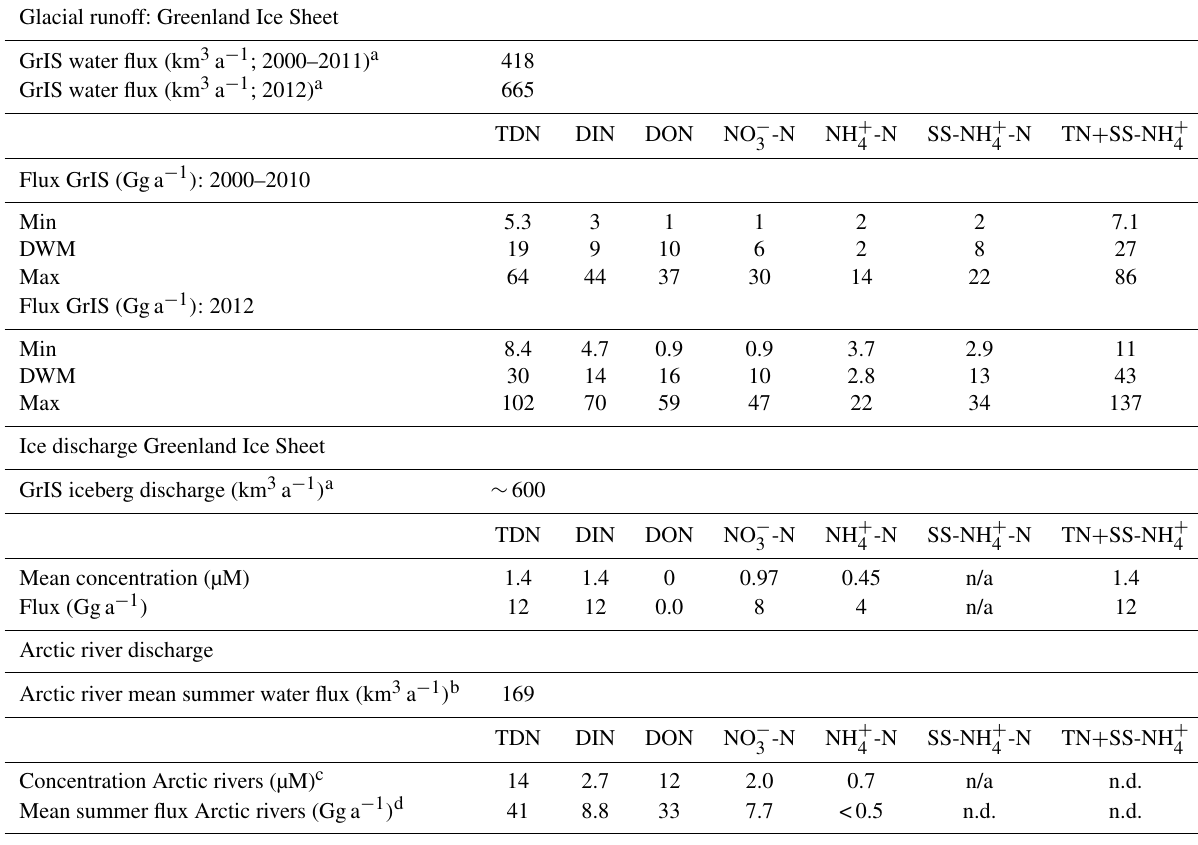
Table 3. Estimates of seasonal fluxes of total dissolved (TDN) and particulate nitrogen (SS-NH + Greenland Ice Sheet in 2000–2010 and